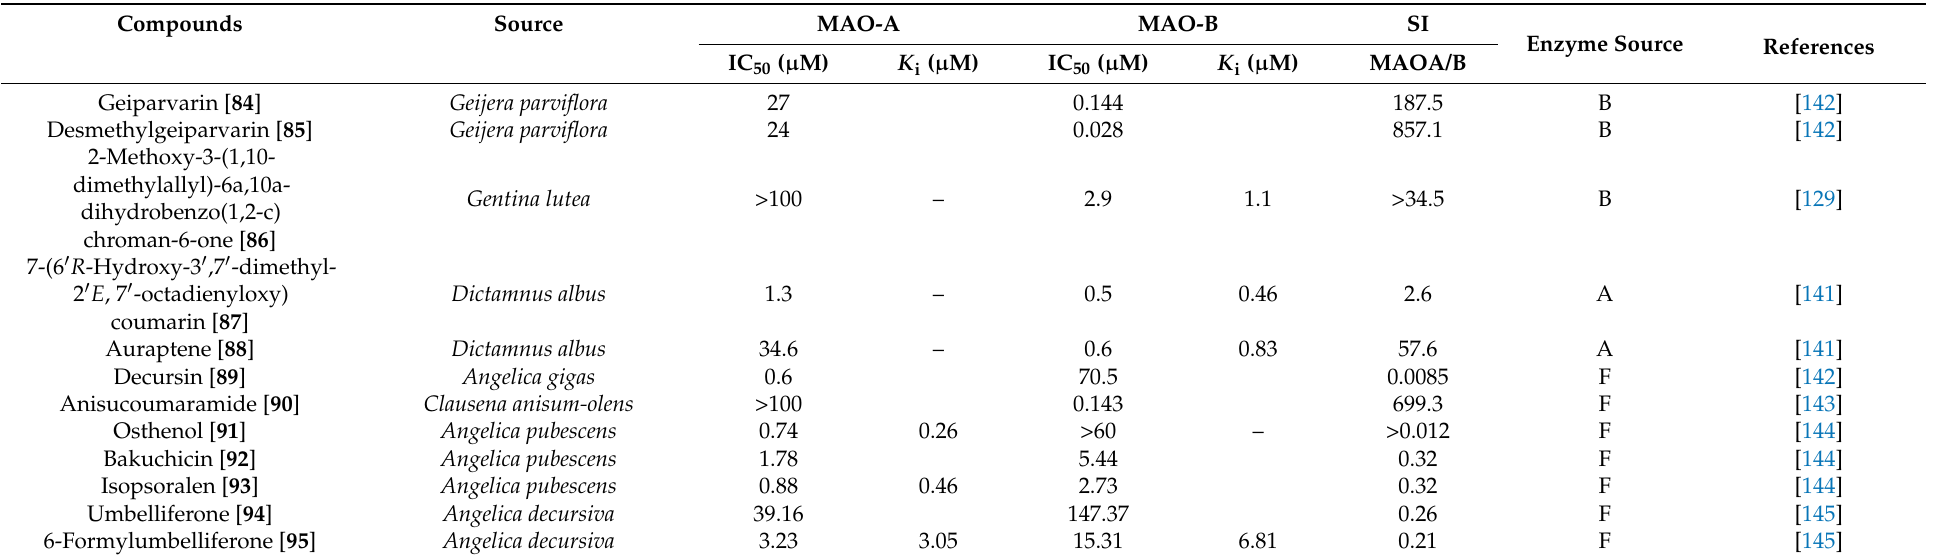
Table 4. Coumarin natural product inhibitors of MAO-A and